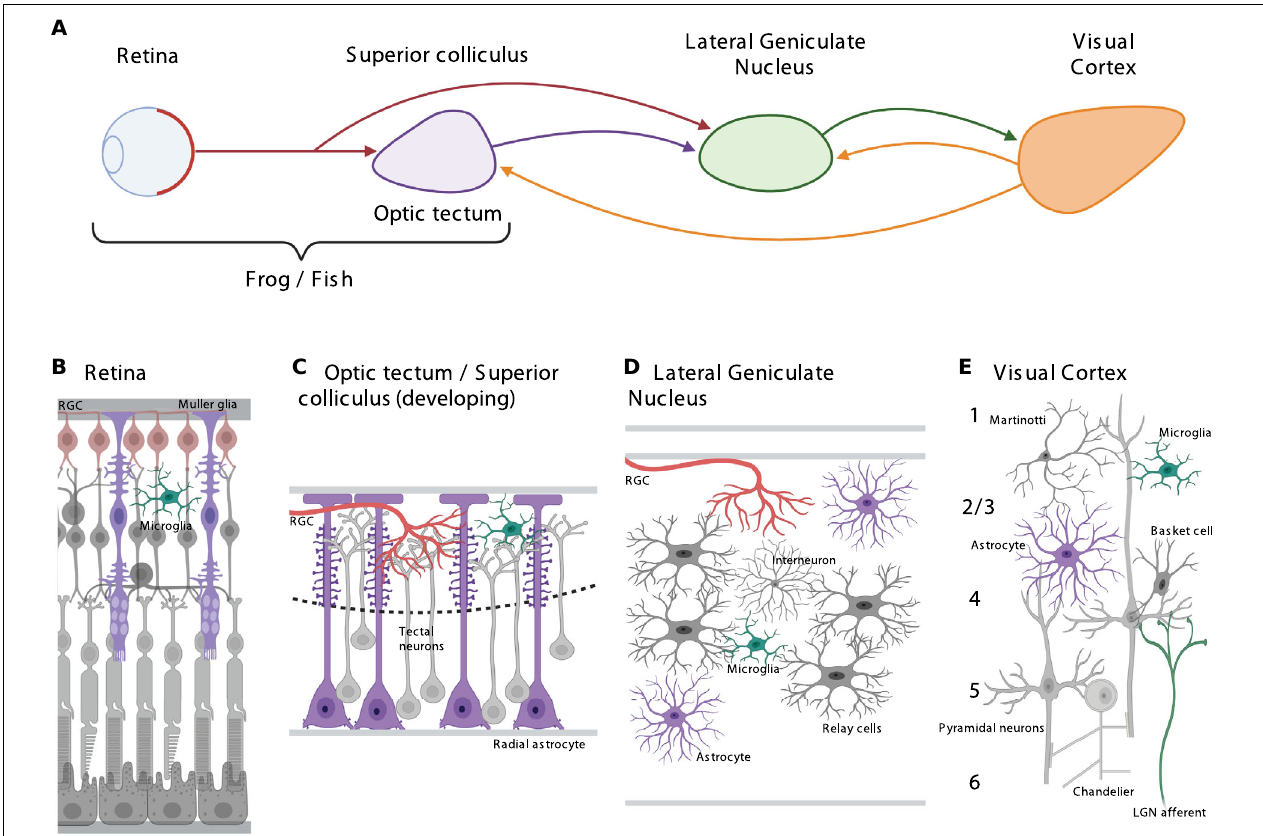
FIGURE 1 | Schematic representations of the vertebrate visual system and the astrocytes and microglia populating each area. (A) Overview of the vertebrate visual system showing the connectivity between major visual areas, in fish and frogs, the retina and optic tectum; and in mammals, the retina, superior colliculus, lateral geniculate nucleus, and the primary visual cortex. (B) Cellular organization of the retina showing Müller glia and microglia. (C) Cellular organization of the optic tectum/developing superior colliculus showing radial astrocytes and microglia. (D) Cellular organization of the lateral geniculate nucleus showing astrocytes and microglia. (E) Cellular organization of the primary visual cortex showing astrocytes and